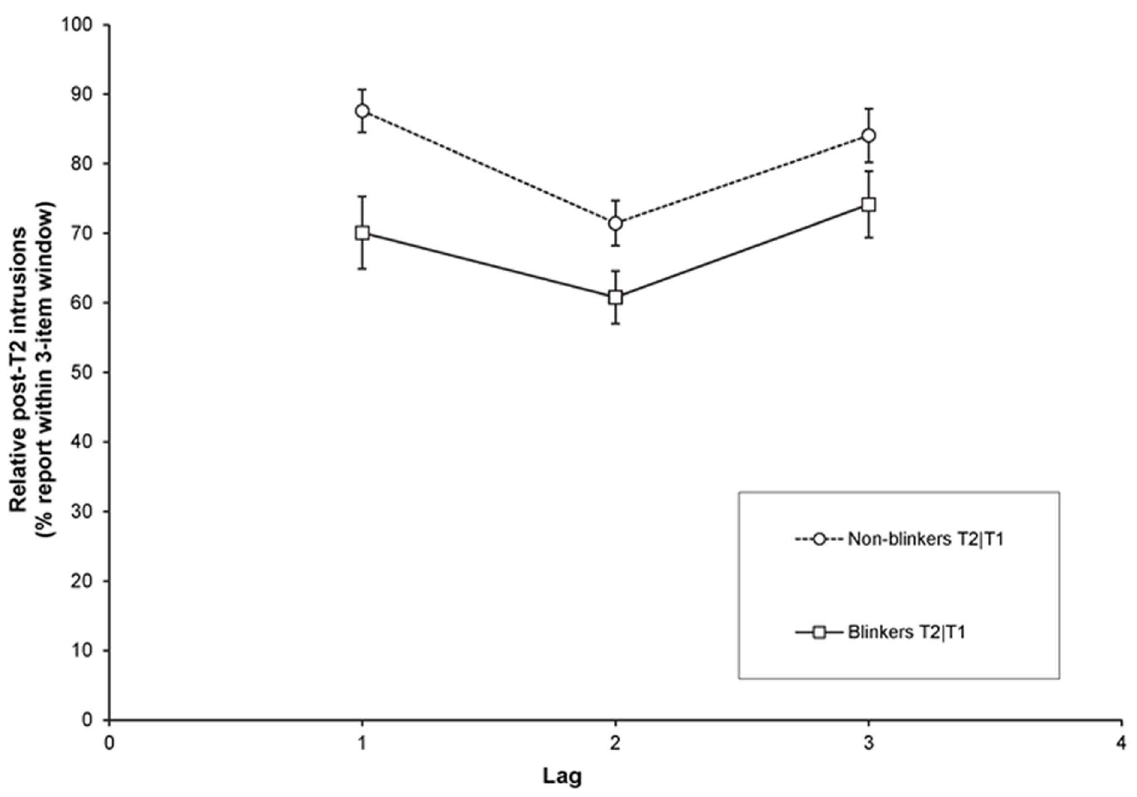
Figure 7. Intrusion errors in Experiment 1b. Percentage of erroneously selected letters (relative to all trials with an incorrect T2 response) presented 1–3 serial positions following T2 as a function of lag, for blinkers and non-blinkers.